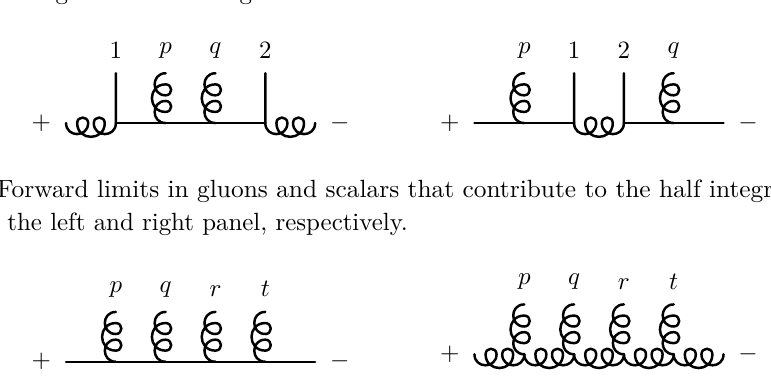
Figure 11 . The four-gluon one-loop half integrand has a contribution with a scalar loop (left panel) and a gluon loop (right